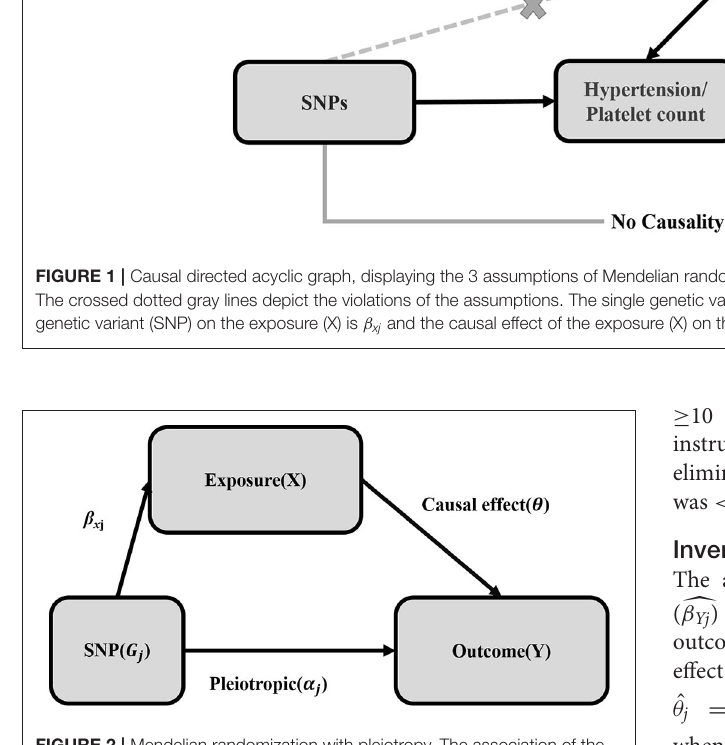
FIGURE 2 | Mendelian randomization with pleiotropy. The association of the genetic variant (SNP) with the outcome (Y) can be decomposed into the indirect effect via exposure (X) (Mendelian randomization: exclusion-restriction assumption) and the direct (pleiotropic) effect. The single genetic variant (SNP) that satisfies the instrumental variable (IV) assumption is G j . The effect of the IV (SNP) on the exposure (X) is β xj , the direct (pleiotropic) effect on the outcome (Y) is α j and the causal effect of the exposure (X) on the outcome (Y) is θ